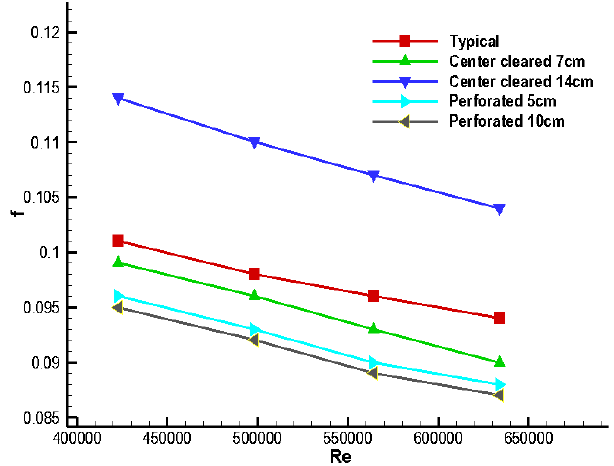
Fig. 12. Variation of Nusselt number at different Reynolds numbers Fig .12 Variation of Nusselt number at different Reynolds numbers